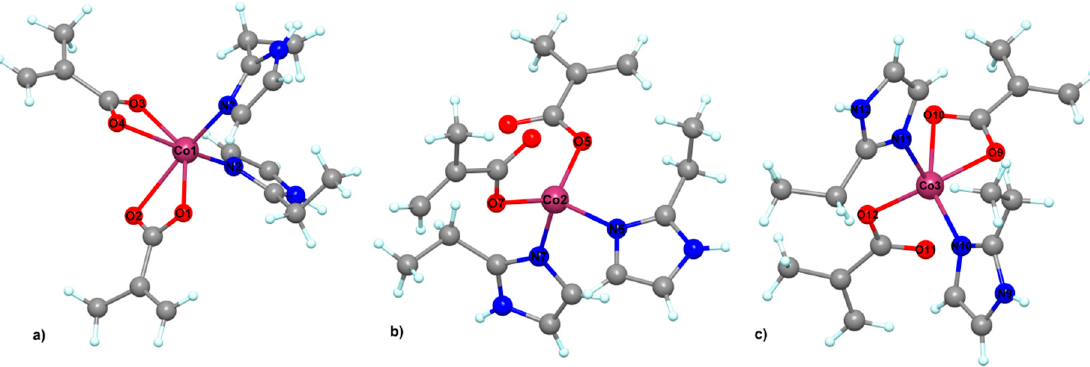
Figure 3. Crystal structure for ( 3 ) with the presence of a different stereochemistry for cobalt ions: ( a ) octahedral, ( b ) tetrahedral and ( c ) square pyramidal.